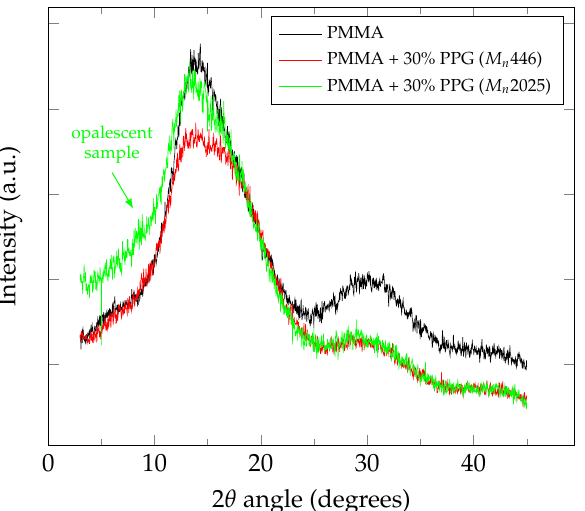
Figure 1. X-ray diffraction shows the difference between the low molecular weight PPG, which is compatible with PMMA at 30 wt.%, and the PPG of higher molecular weight, which causes opacity at such